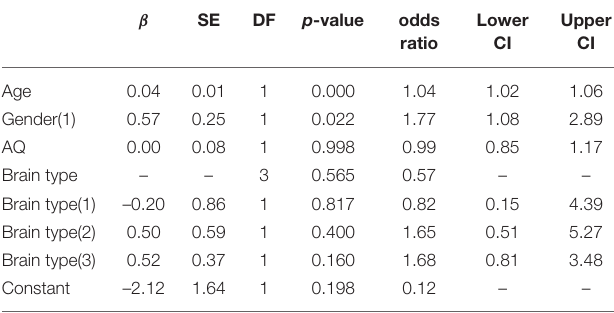
FIGURE 3 | Significant differences between the two clusters. (A) Distribution of age in the two clusters. Overlaid violin plots on the right-hand side further detail the age distribution of participants in each cluster. (B) Number of participants with each gender in the two clusters. (C) Number of participants with each cognitive brain type in the two clusters. (D) Distribution of AQ in the two clusters. Overlaid violin plots on the right-hand side further detail the AQ distribution of participants in each cluster. *Indicates significant differences. TABLE 4 | Results of logistic regression with age, gender, brain type, and AQ